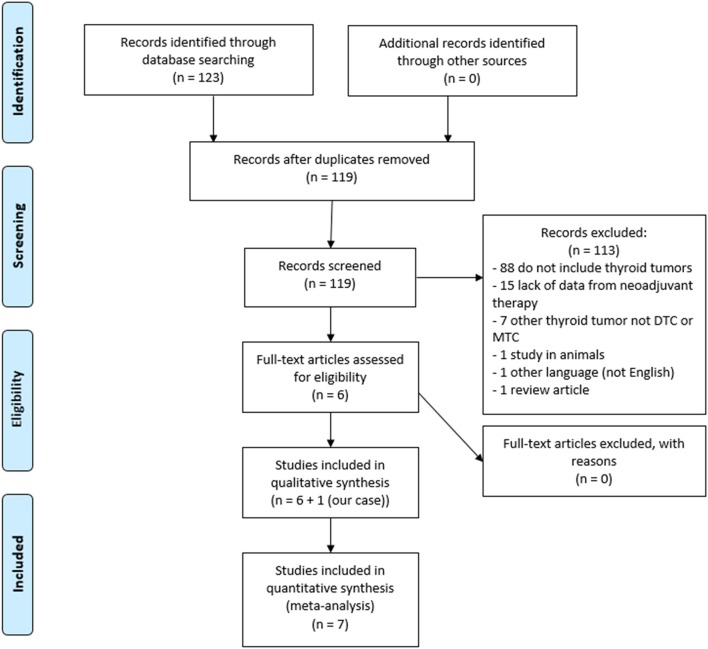
Flow diagram of reference identification and selection.